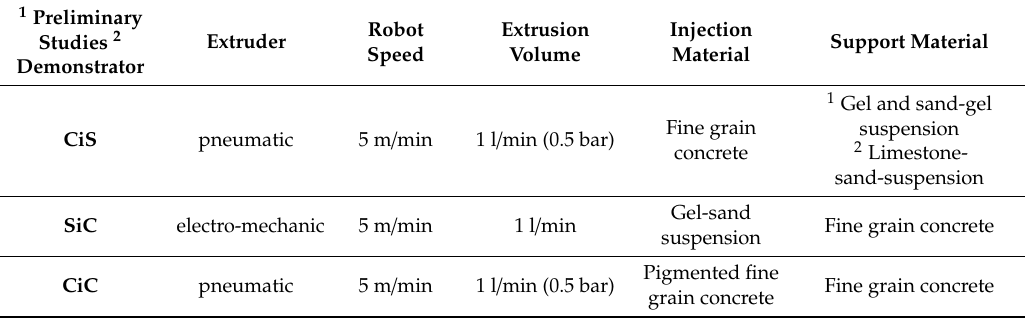
Table 2. Overview of the fabrication setup, parameters and materials used during the di ff erent